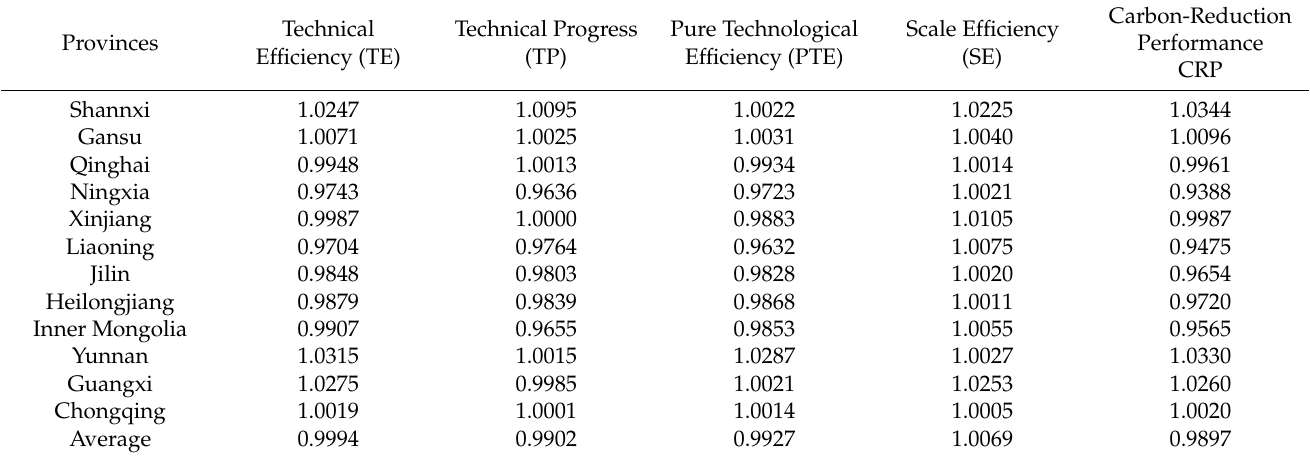
Table 6. Comparison of carbon reduction and its contributors among the provinces along the